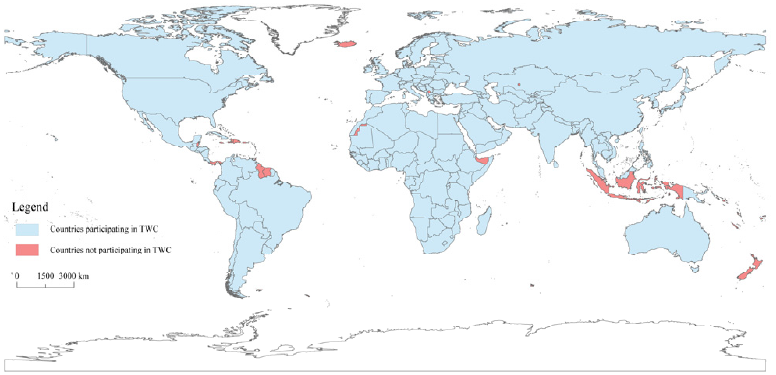
Figure 2. Spatial distribution of countries participating in TWC.